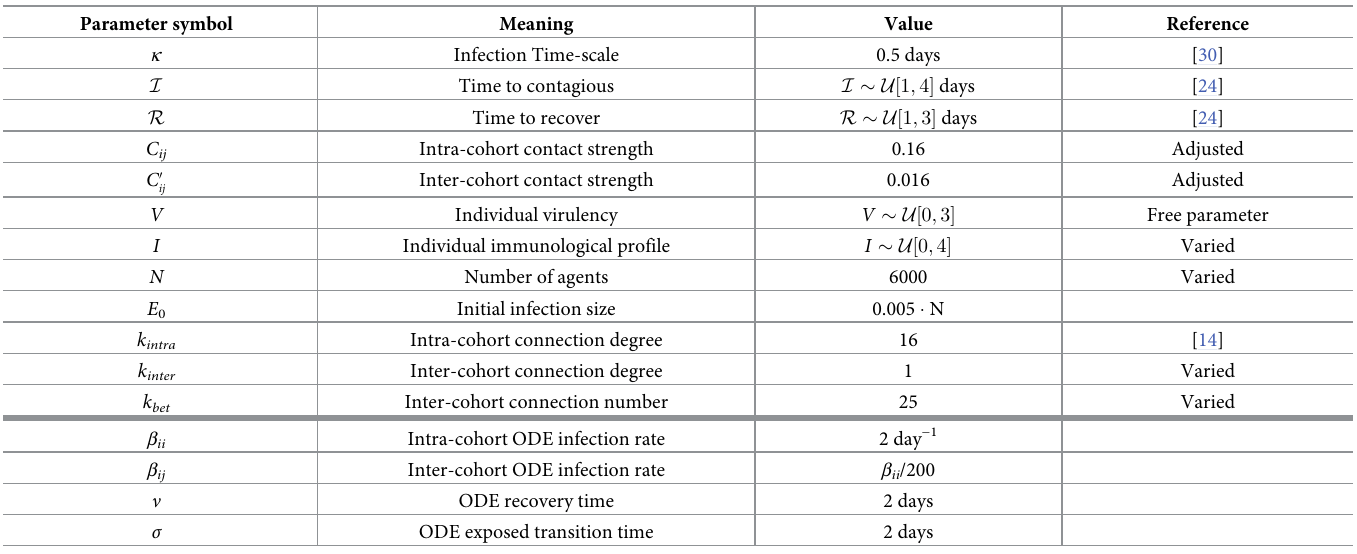
Table 1. Table of parameters used in ODE model and ABM.